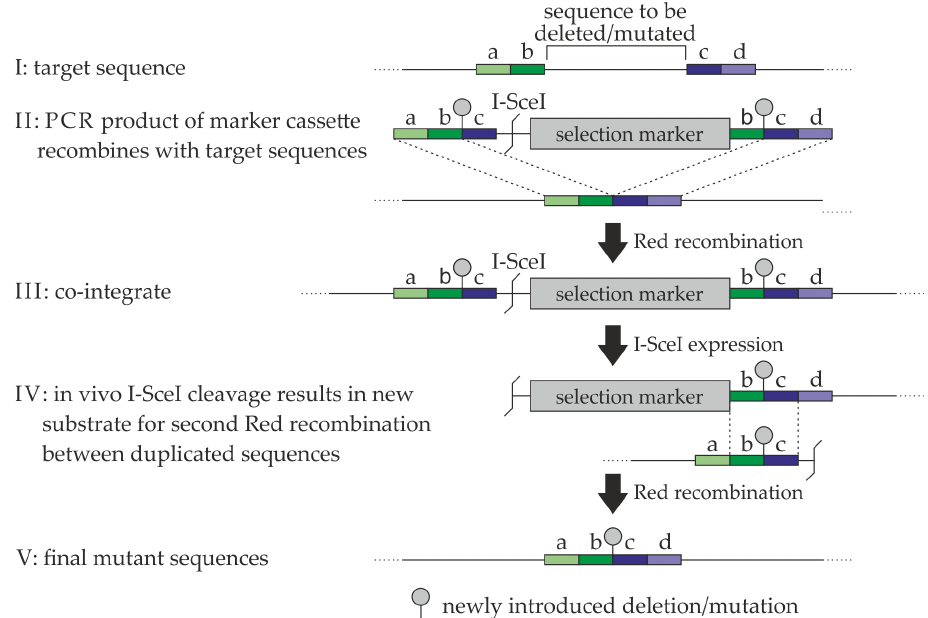
Figure 10. Schematic view of the generation of recombinant HCMVs. For a stepwise description of the procedure, see Results and Methods section. a–d, defined stretches of 50 nucleotides for primer design; adapted with permission from Tischer et al., 2010 [65]. © 2022, Springer Science+Business Media, LLC.